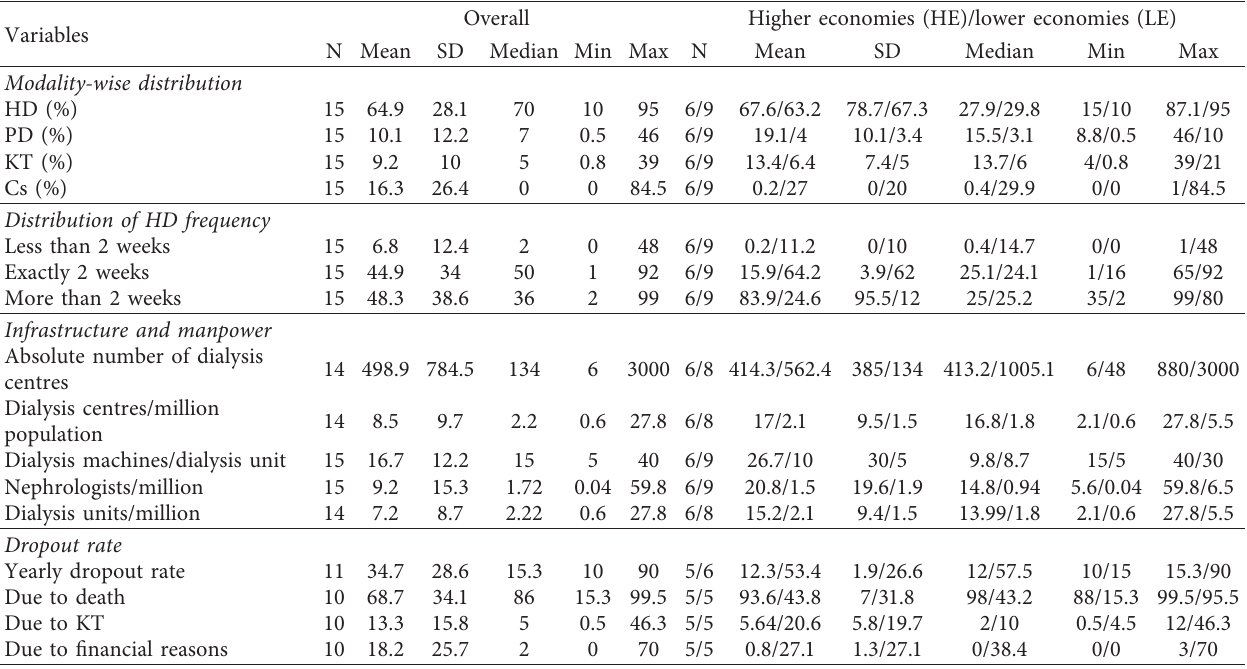
Table 2: ESKD treatment demographics in SA and